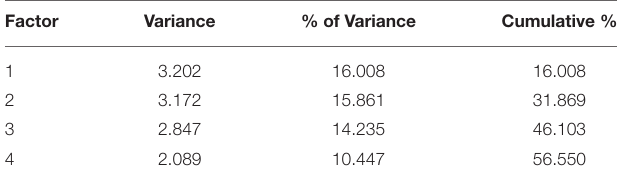
TABLE 2 | Variance explained by the